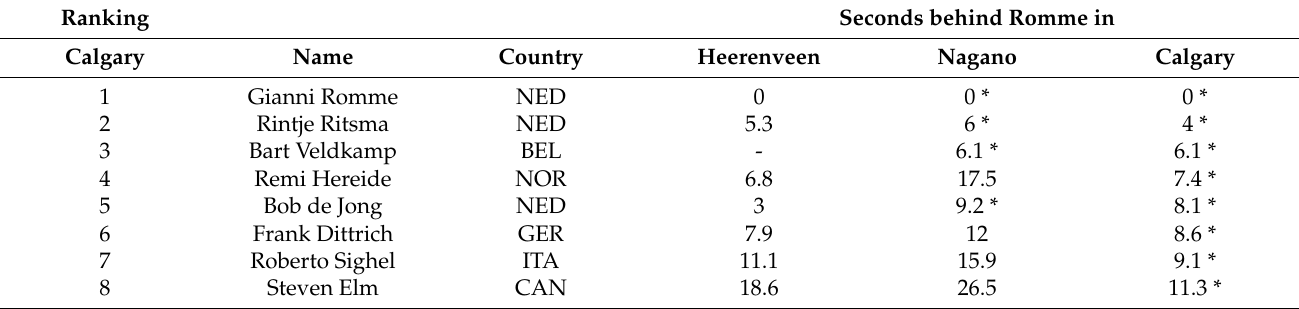
Table 5. Differences with Romme of a number of elite skaters at three consecutive 5000 m races. Ranking Seconds behind Romme